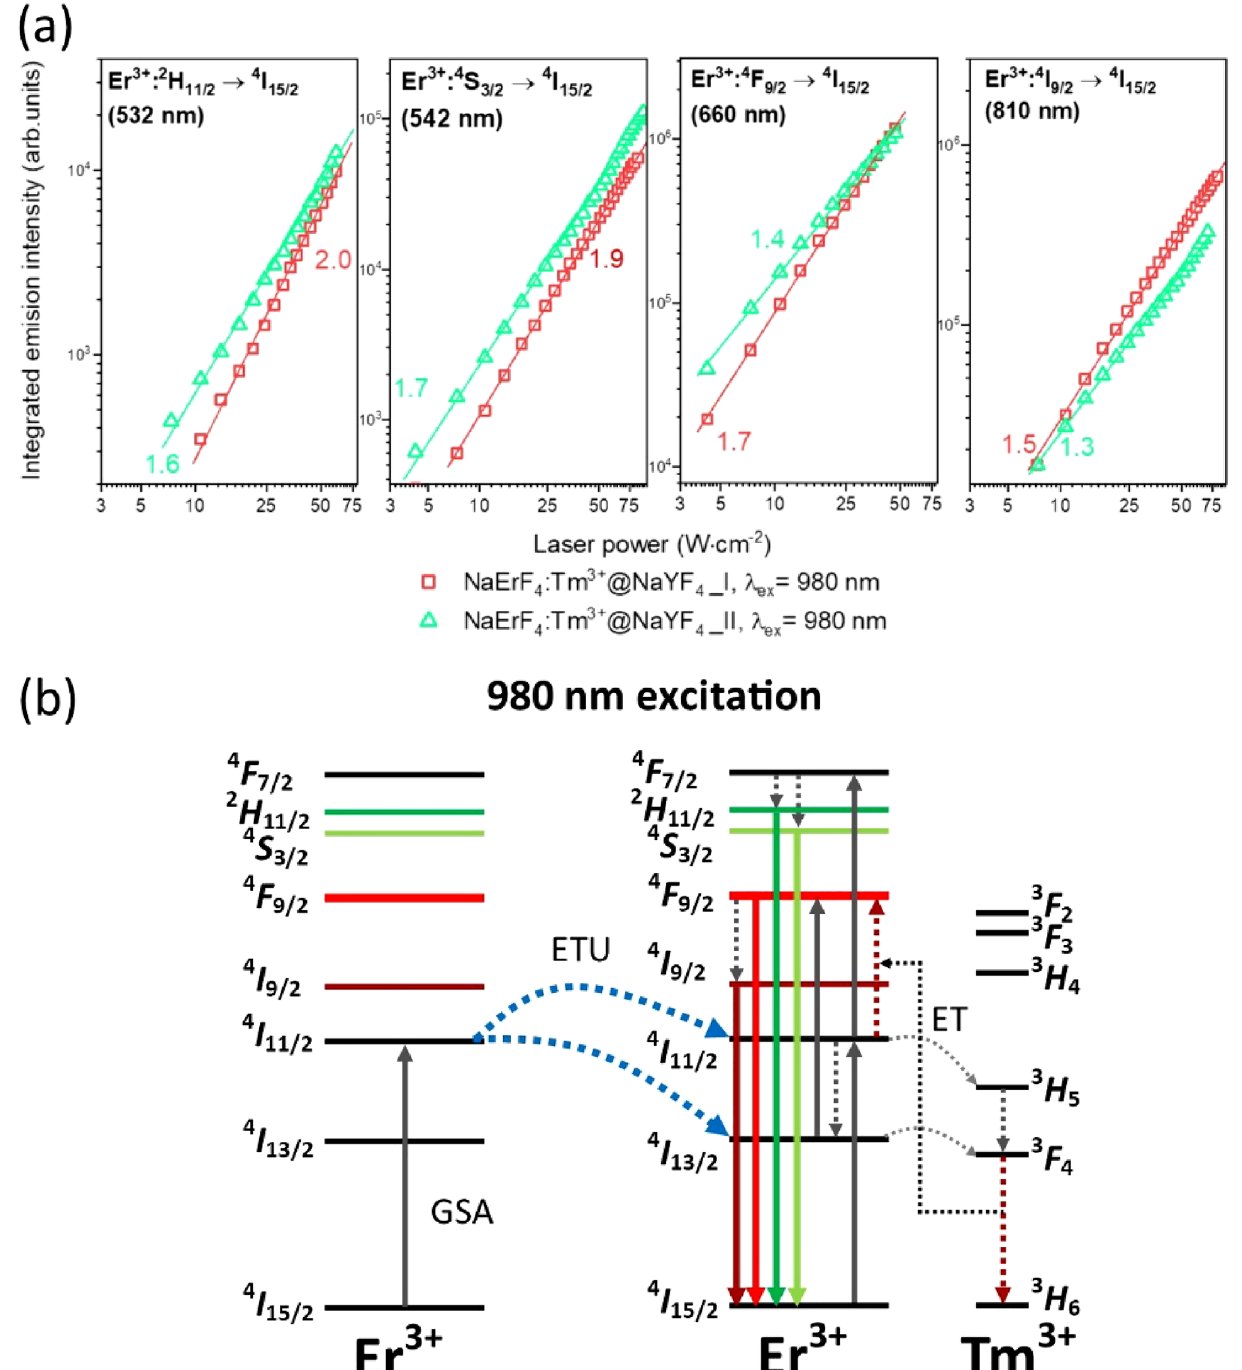
Figure 4. ( a ) Double-logarithmic plots of the upconversion emission intensity versus laser power density, measured for the NaErF 4 :Tm 3+ @NaYF 4 NPs and ( b ) proposed UC mechanisms responsible for the observations under 980 nm laser